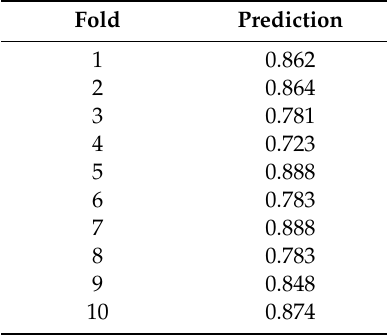
Table 2. Variability score of Dataset 1 of random subspace with k-NN as base classifier.